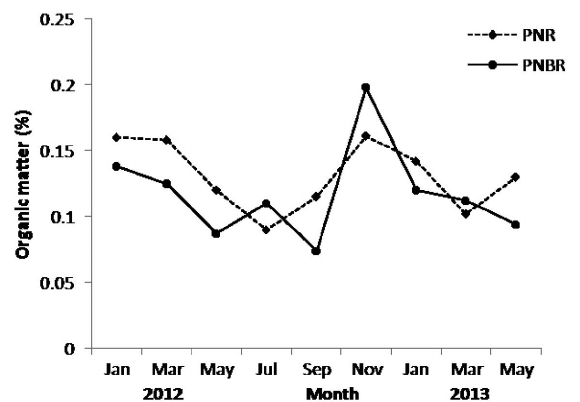
Fig. 3. – Percentage organic matter of the sediment at Site 1, Payyan- nur (PNR), and Site 2, Panambur (PNBR).